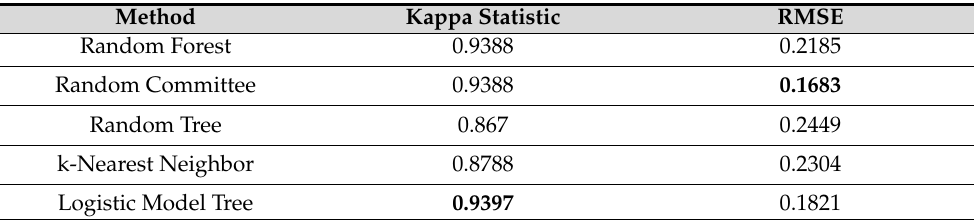
Table 10. Kappa statistics and RMSE values of algorithms on cancer prediction with all attributes. (Illustrations by the authors).